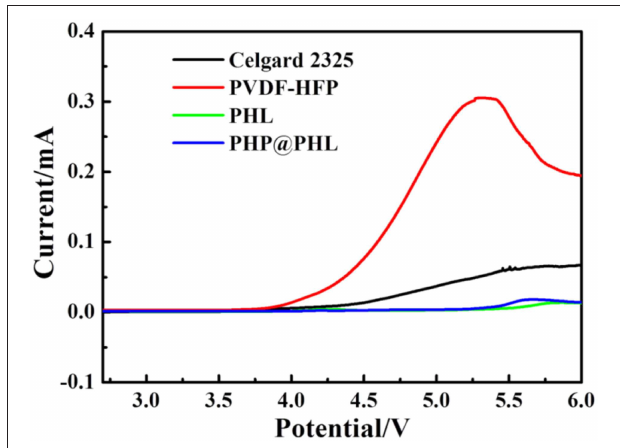
FIGURE 5 | Linear sweep voltammograms of the four electrolytes at a scan rate of 0.5 mV/s